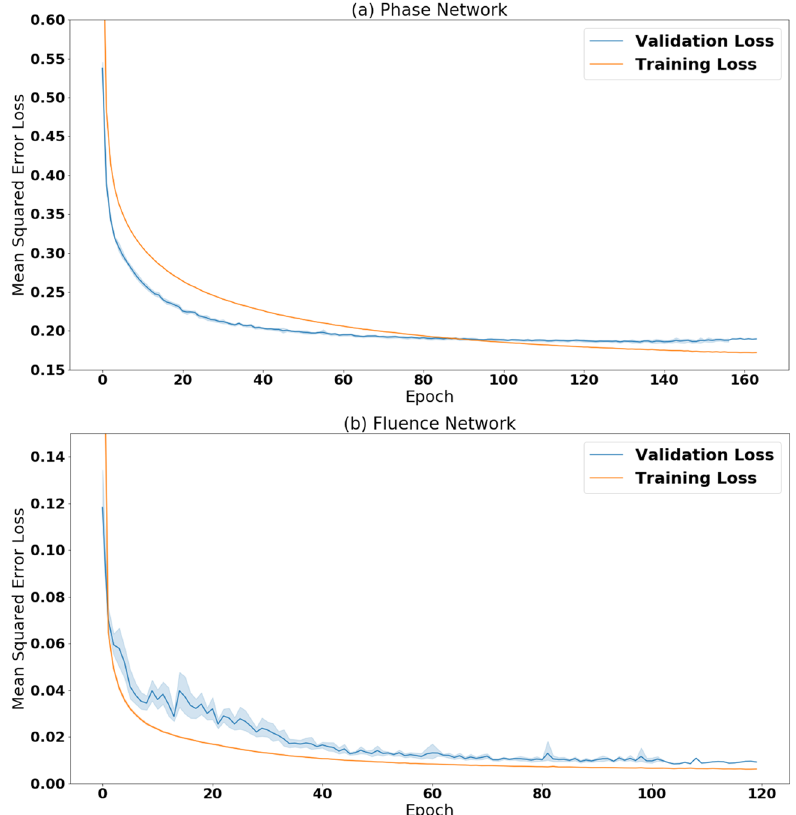
Figure 8. Training and validation loss, measured by the mean squared error, over time. Loss curves show the average (solid line) and one standard deviation (shaded region) for the ten folds of cross validation. (a) Simulated few-cycle phase network. (b) Simulated few-cycle fluence